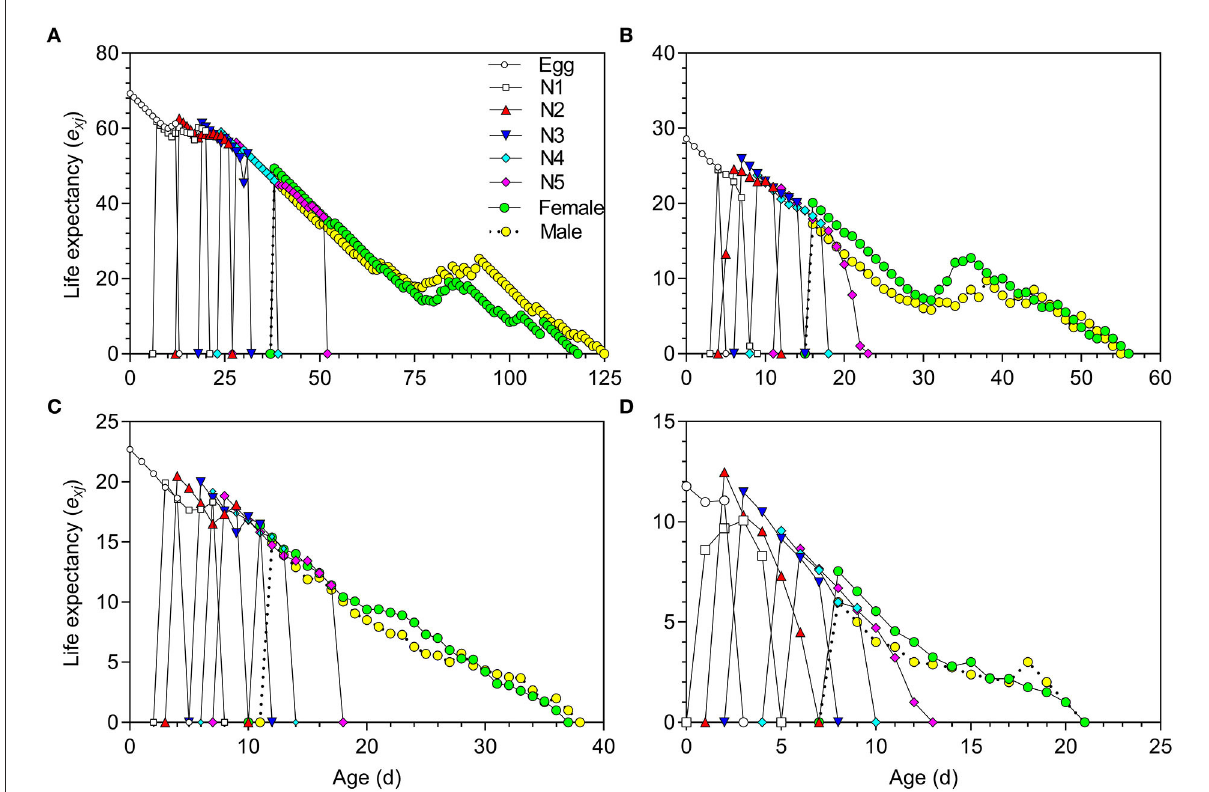
FIGURE3 Life expectancy ( e xj ) of Orius strigicollis fed on Frankliniella occidentalis at 18.5 ◦ C (A) , 23.5 ◦ C (B) , 27 ◦ C (C) , and 33 ◦ C (D) .